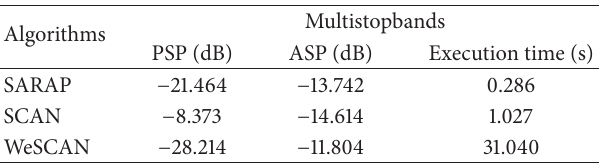
Table 3: Algorithms comparison for suppressing narrow interfer- ence in